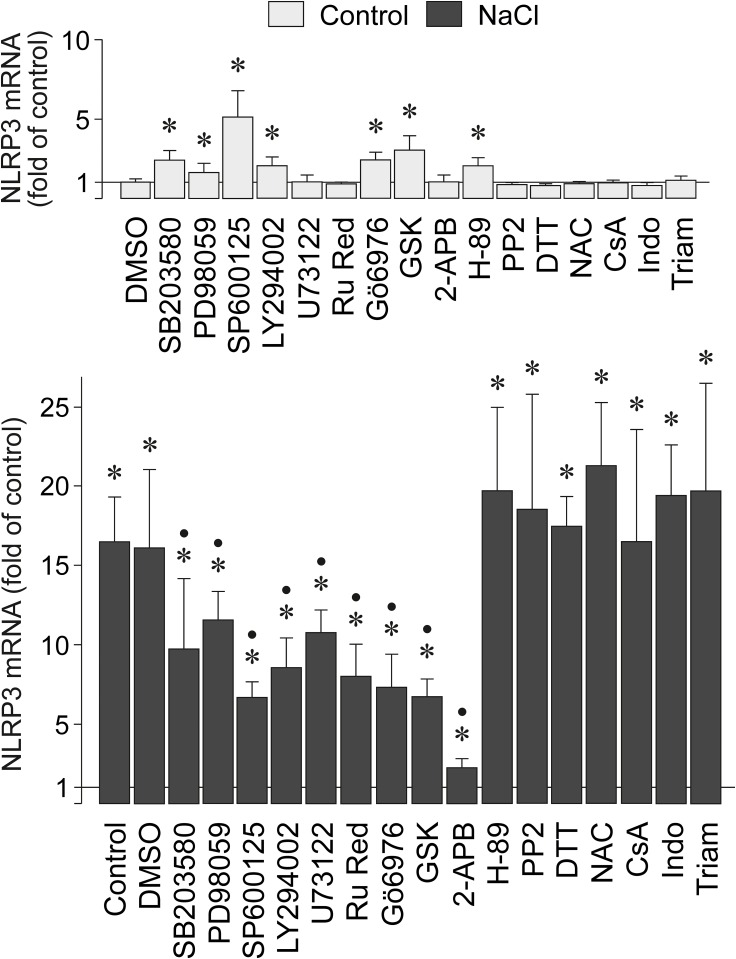
Intracellular signaling involved in the NaCl-induced expression of the NLRP3 gene in RPE cells.The level of NLRP3 mRNA was determined with real-time RT-PCR analysis in cells cultured 6 h in iso- (control) and hyperosmotic (+ 100 mM NaCl) media. The following agents were tested: the inhibitor of p38 MAPK activation, SB203580 (10 μM), the inhibitor of ERK1/2 activation, PD98059 (20 μM), the JNK inhibitor SP600125 (10 μM), the inhibitor of PI3K-related kinases, LY294002 (5 μM), the PLCγ inhibitor U73122 (4 μM), the inhibitor of calcium-binding proteins, ruthenium red (Ru Red; 30 μM), the inhibitor of PKCα/β, Gö6976 (1 μM), the SGK inhibitor GSK650394 (GSK; 1 μM), the inhibitor of store-operated calcium entry channels, IP3 receptors, and TRP channels, 2-APB (100 μM), the protein kinase A inhibitor H-89 (1 μM), the inhibitor of Src tyrosine kinases, PP2 (100 nM), the reducing agent dithiothreitol (DTT; 3 mM), the ROS inhibitor NAC (1 mM), the inhibitor of mitochondrial permeability transition, cyclosporin A (CsA; 1 μM), the cyclooxygenase inhibitor indomethacin (Indo; 10 μM), and the antiinflammatory glucocorticoid triamcinolone acetonide (Triam; 50 μM). Vehicle control was made with dimethylsulfoxide (DMSO; 1:1000). Means ± SEM of 3–8 independent experiments using cell lines from different donors. Significant difference vs. unstimulated control: *P<0.05. Significant difference vs. NaCl control: ●P<0.05.